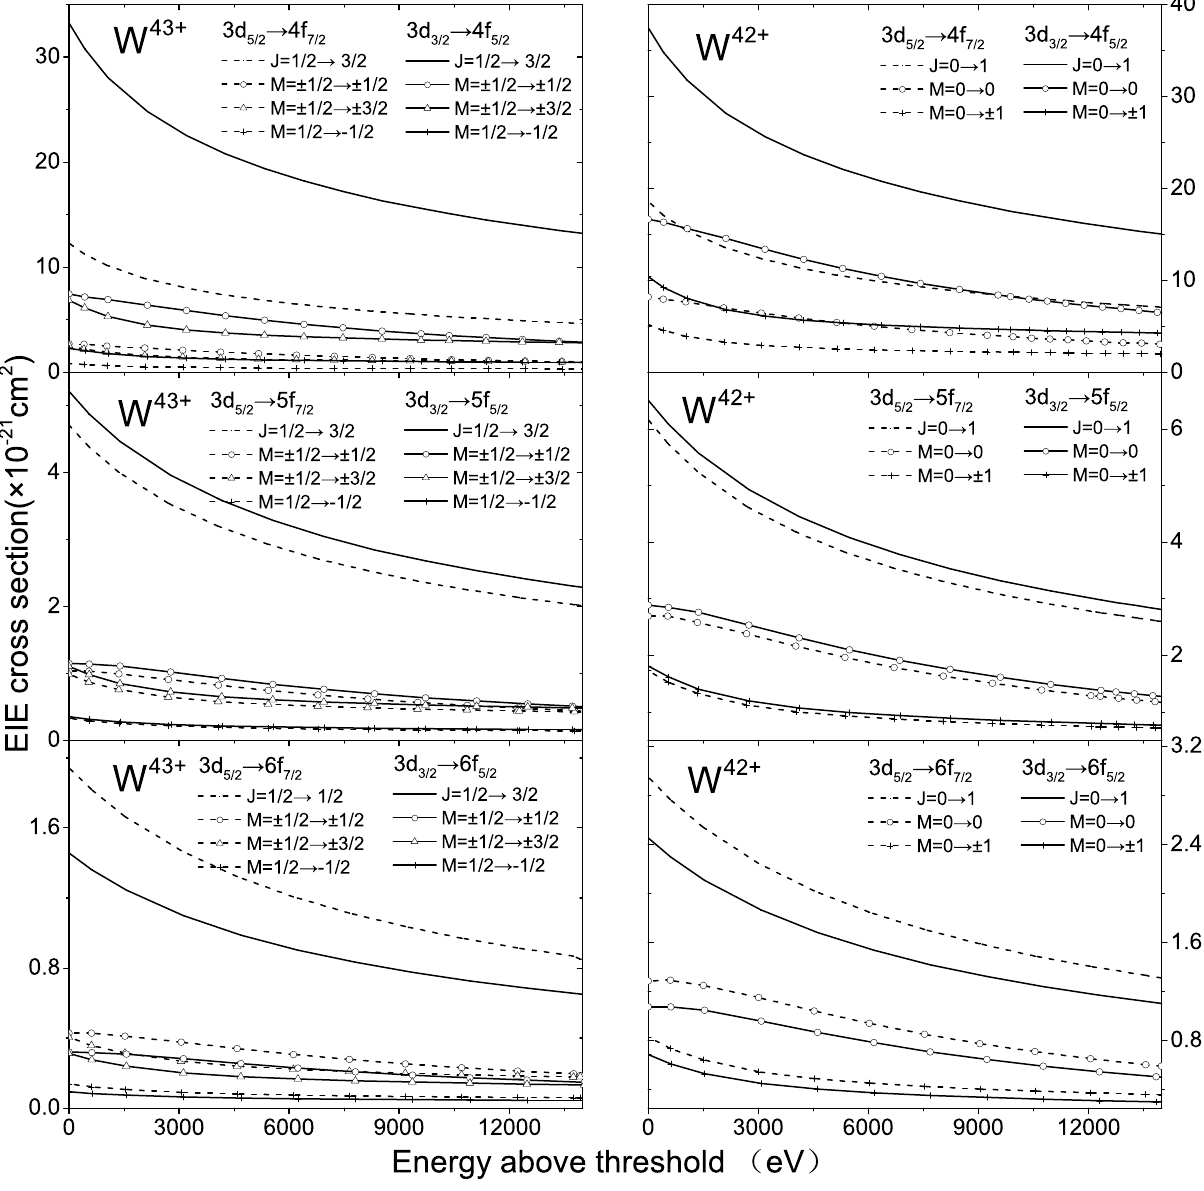
Figure 2. The presently calculated total and magnetic sub-level cross-sections for electron-impact excitations 3 d panel) and W 42+ (right panel) ions as a function of incident electron